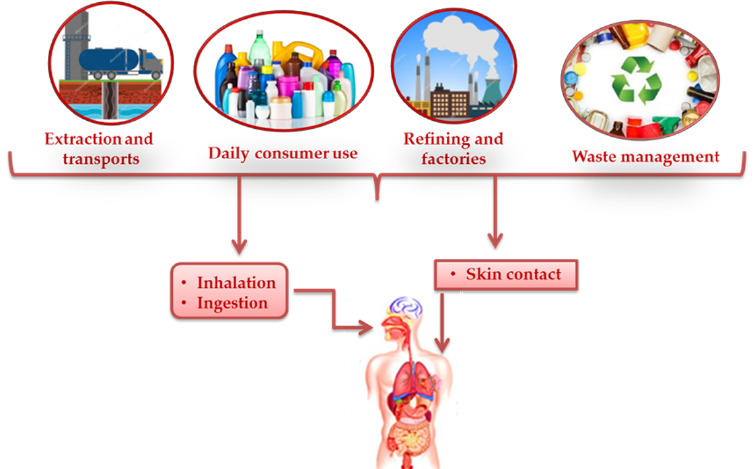
Figure 1. Plastic and human health. Humans are exposed to numerous kinds of toxic chemicals and microplastics through ingestion, inhalation, and direct skin contact, all along the plastic life cycle. Tissue-accumulation kinetics and distribution pattern strongly depend on the